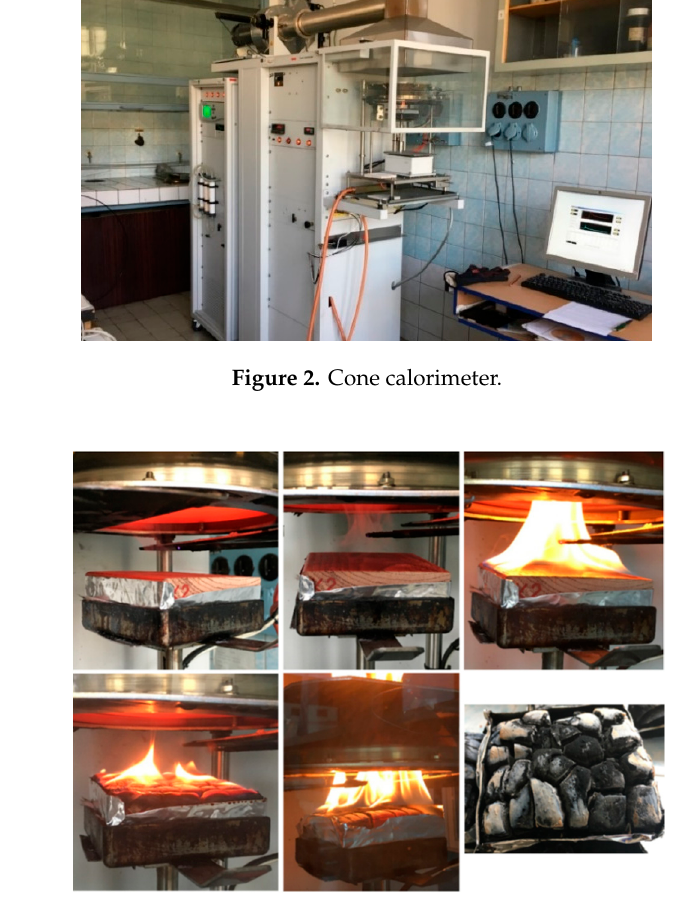
Figure 3. Samples tested in the cone calorimeter.